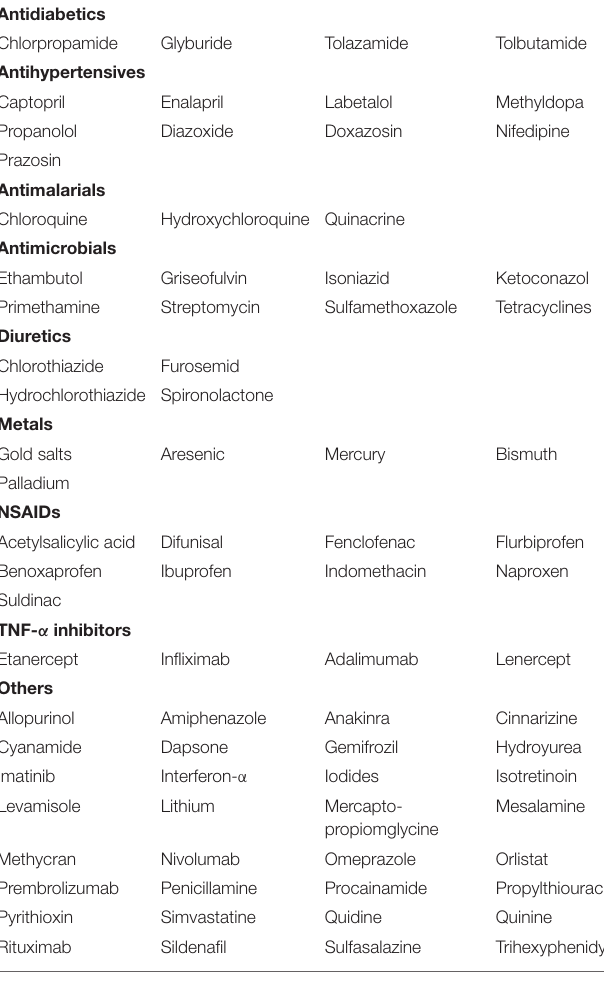
TABLE 2 | Drugs associated with lichen planus like